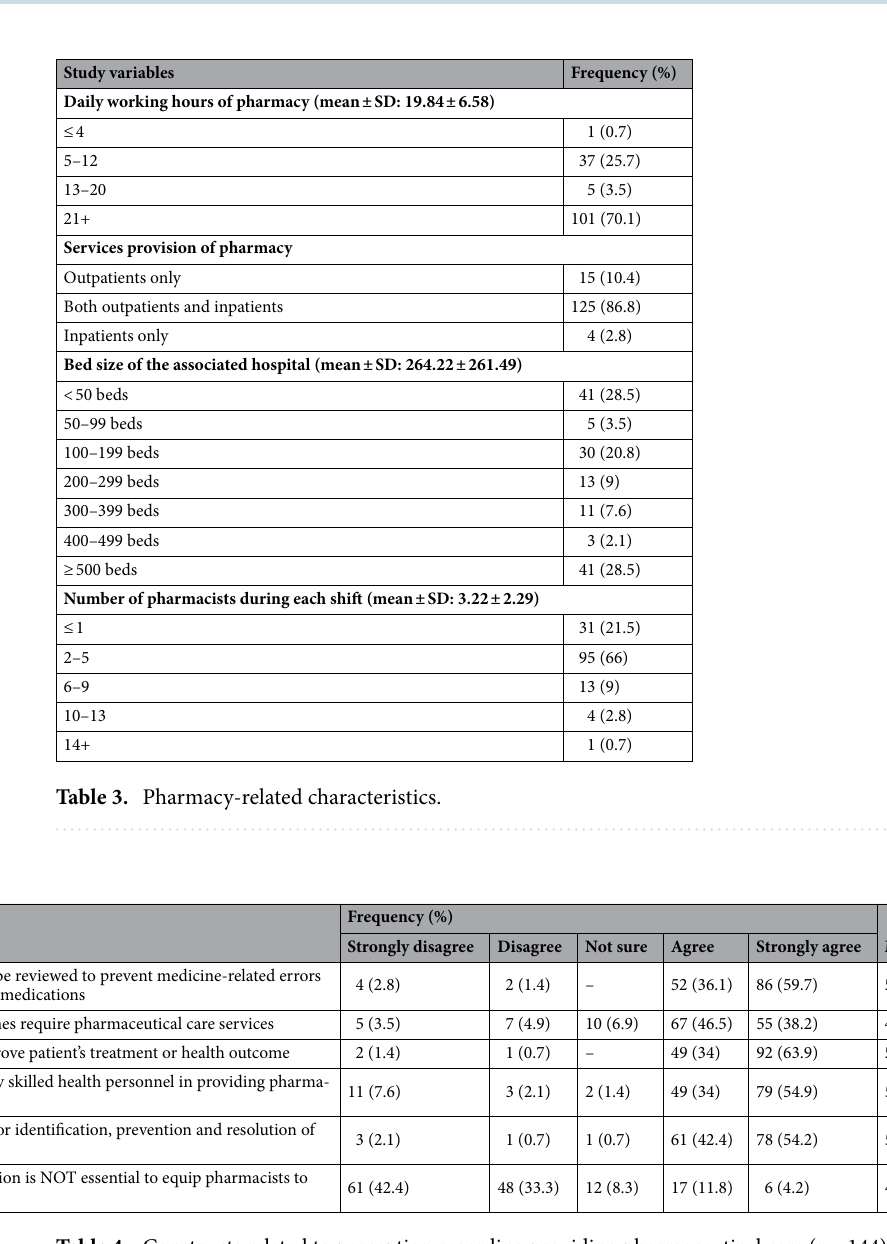
Table 4. Constructs related to perception regarding providing pharmaceutical care (n = 144). *The statement is negative and hence reversed while